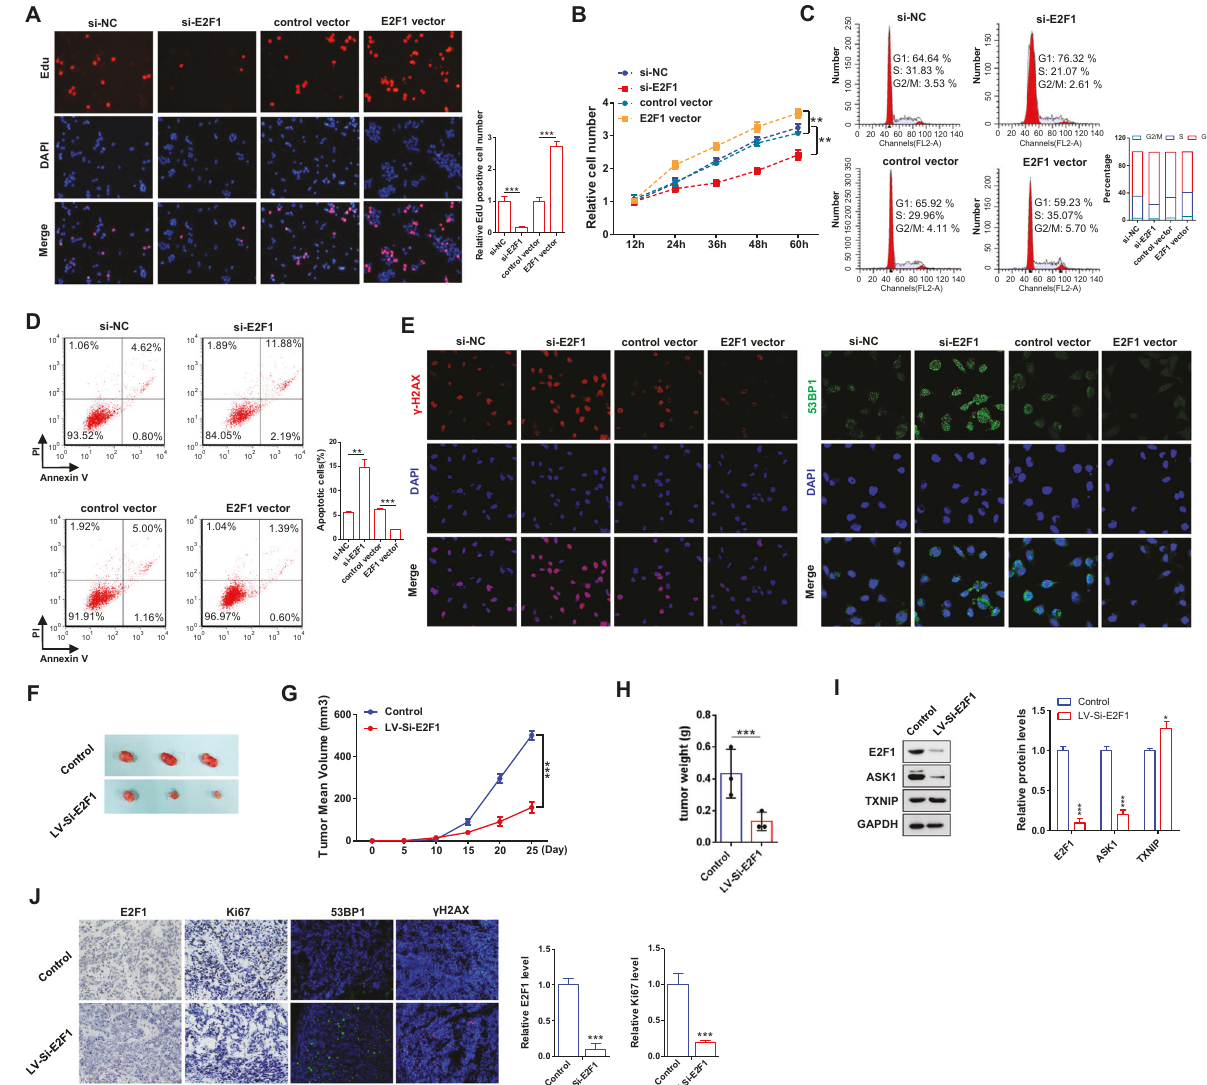
Fig. 2 E2F1 functions as an oncogene in GC. A , B Cell proliferation assays (EdU and CCK8) were performed in MKN-45 cells transfected with si-E2F1 or E2F1 vector. C , D Representative images and histogram statistics from cell cycle and apoptosis. E Immuno fl uorescence staining of DNA damage markers, γ H2AX and 53BP1, in MKN-45 cells transfected with si-E2F1 or E2F1 vector. F Representative images of tumors from mice implanted with control MKN-45 cells and E2F1-inhibiting MKN-45 cells. The cells were implanted subcutaneously into 6-week-old SCID mice (3 mice per group). G The time course of tumor growth. Tumor volume was measured every 5 days for 25 days after the inoculation. H The tumor weights of two groups. I Western blotting analysis of E2F1, ASK1 and TXNIP protein levels in tumors from the implanted mice. J E2F1, Ki67 and 53BP1, γ H2AX staining of tumor sections obtained from two groups. All data are shown as the mean ± S.E. of three separate experiments. * P < 0.05; ** P < 0.01; *** P < 0.001. accumulation (Fig. 2A – E). Therefore, the above results further control cells, E2F1 inhibition led to an increase of G1-phase con fi rmed that E2F1 promote GC proliferation, G1/S transition population, and a concomitant decrease of cell number at the S and suppress apoptosis and DNA damage of GC cells in vitro. phase and G2/M phase (Fig. 2C). Apoptosis assays revealed that To further study the effects of E2F1 on GC tumorigenesis in vivo, E2F1 knockdown result in increased cell apoptosis (Fig. 2D). MKN-45 cells were infected with si-E2F1 lentivirus to suppress Moreover, we determined the effect of E2F1 on DNA damage. E2F1 (Supplementary Fig. 2A, B), and then the cells were Immuno fl uorescence showed that interference of E2F1 expres- implanted to nude mice to establish a xenograft mice model. sion substantially increased the accumulation of H2AX histone Consistent with in vitro results, E2F1 knockdown signi fi cantly protein ( γ H2AX) and 53BP1, markers of DNA double-strand delayed GC tumor growth (Fig. 2F – H). Moreover, tumors from breaks (DSB) [30 – 32], compared to transfection with si-NC E2F1 silencing group showed decreased E2F1, ASK1 and increased (Fig. 2E). Conversely, overexpressing E2F1 markedly increased TXNIP levels than control group (Fig. 2I). H&E staining showed ASK1 protein level and decreased TXNIP protein level (Supple- decreased mitosis in E2F1 inhibition group compared with the mentary Fig. 1C). The measurement of functional parameters control group, while E2F1 and Ki-67 staining revealed less E2F1 revealed that E2F1 overexpression promote GC cell proliferation, protein level and decreased proliferative activity (Fig. 2J). These G1/S transition and suppress cell apoptosis and DSB